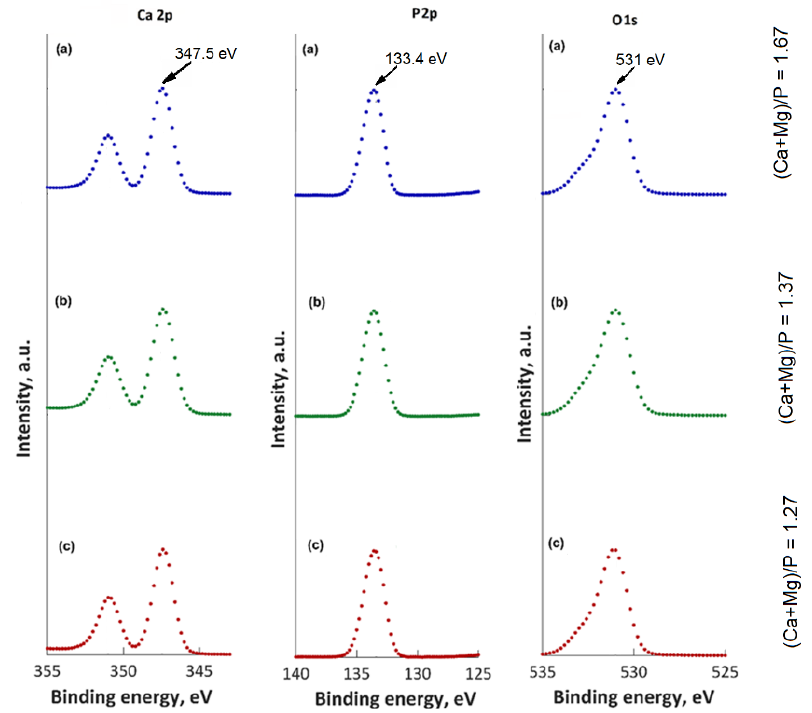
Figure 11. High-resolution XPS spectra for Ca 2p, P2p, and O 1 s spectra of 10 MgHApCh-0 ( a ), 10 MgHApCh-3 ( b ), and 10 MgHApCh-6 ( c ) layers.